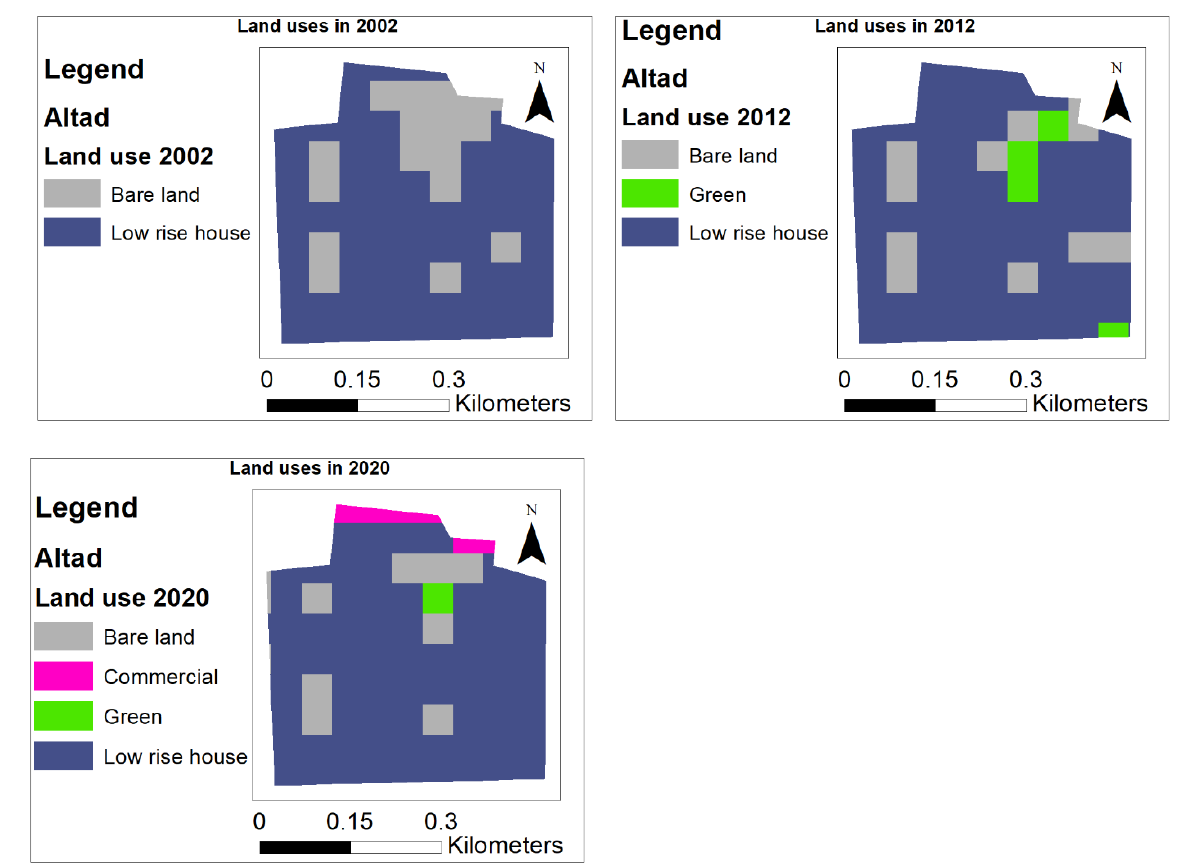
Figure 5. The land use composition for 2002, 2012, and 2020 in the relocation area (Altad neighborhood).